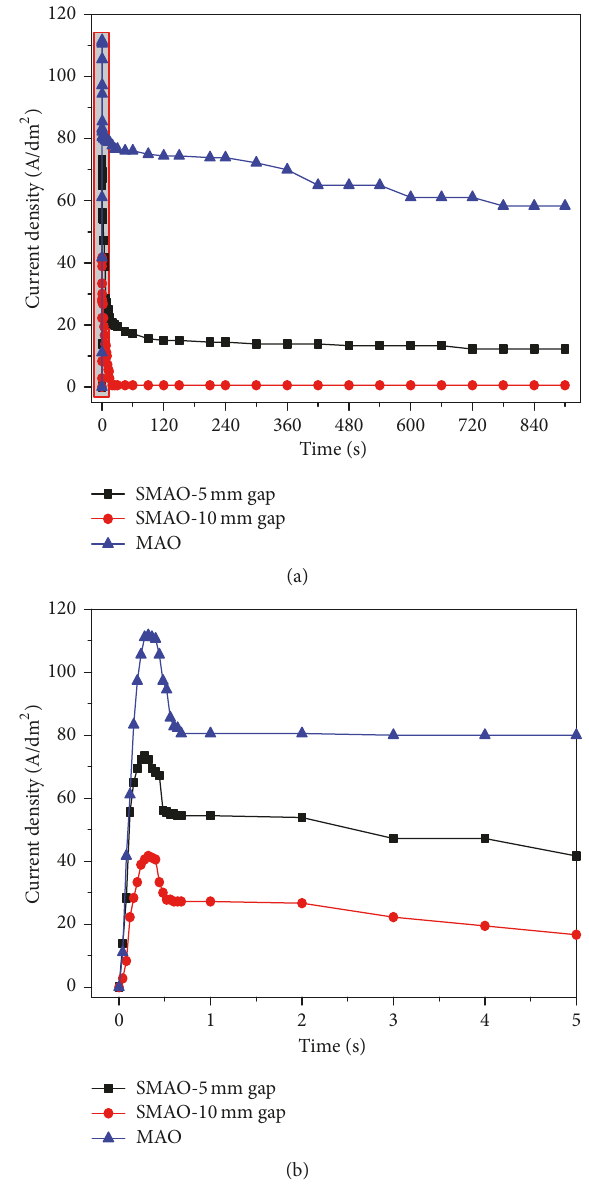
Figure 8: Current density-time responses of SMAO and MAO for A356 alloy based on AC1 setting showing (a) long-term and (b) transient